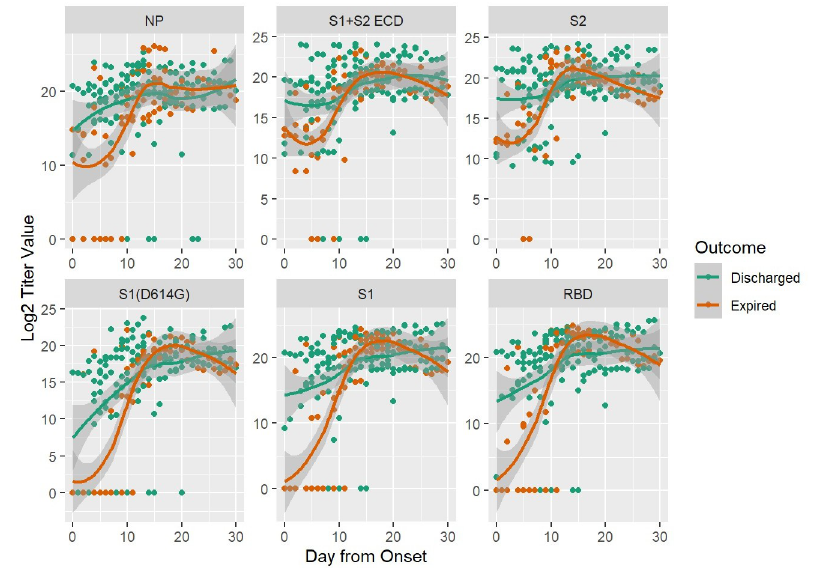
Fig 1. Anti-SARS CoV2 IgG Antibody Kinetics After Symptom Onset. Antibody titers at different days after onset were measured by the multiplexed beads array as described in Methods. Displayed are specific IgG antibody titer values (log transformed) in expired (orange) and discharged (green) groups of patients targeting the nucleocapsid protein (NP) and five spike protein components, i.e., S1+S2 ECD, S2, S1 (D614G), S1 and RBD. Dots are titer values for each patient at the corresponding day from onset; lines are smoothed regression fit to the observed data with 95% confidence interval bands.